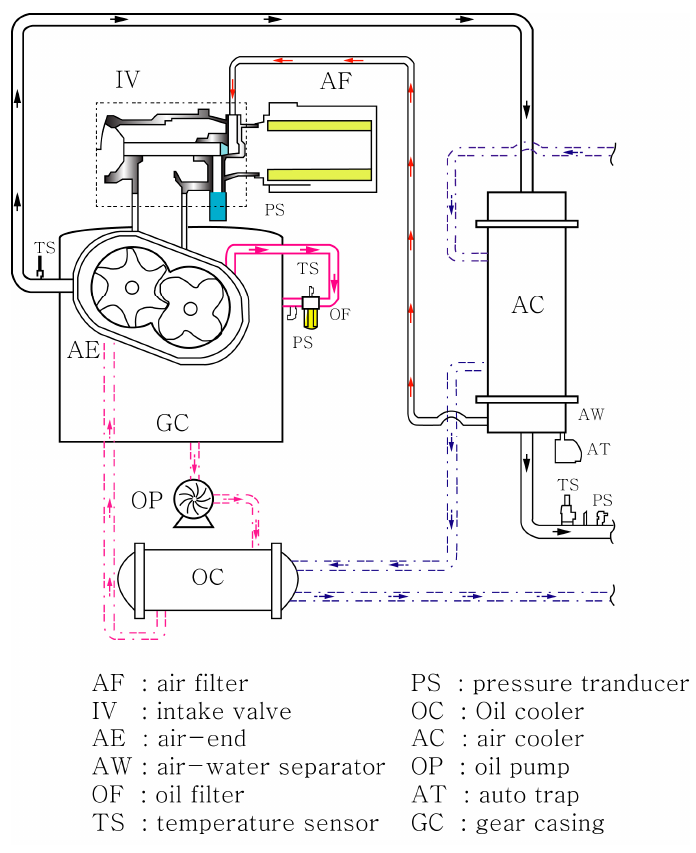
Figure 8. Schematic diagram of the test bench.